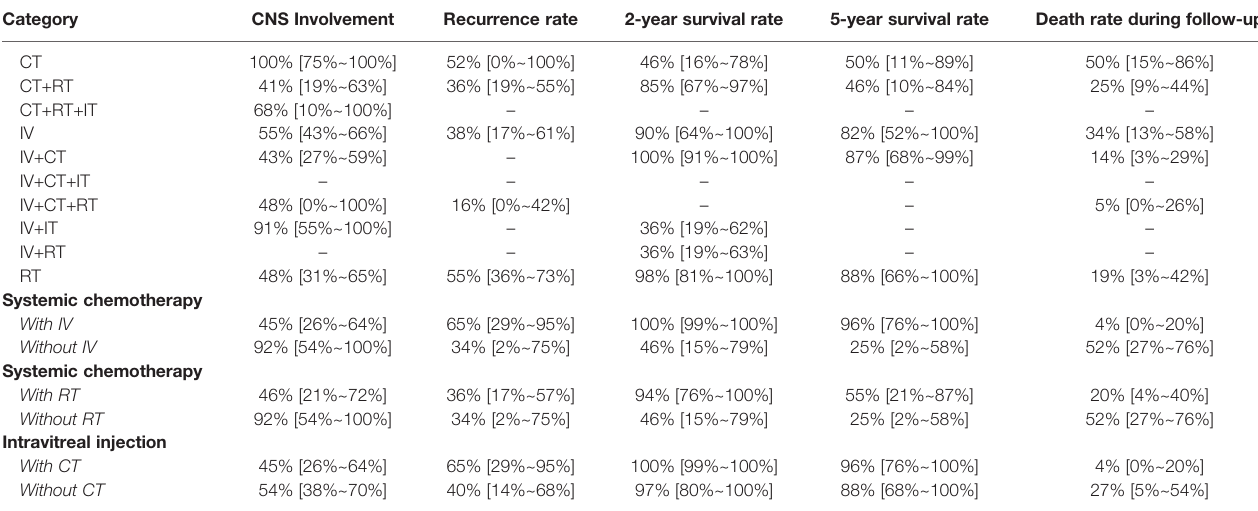
TABLE 5 | Pooling results about treatment strategy and ef fi cacy for PIOL patients without CNS involvement at fi